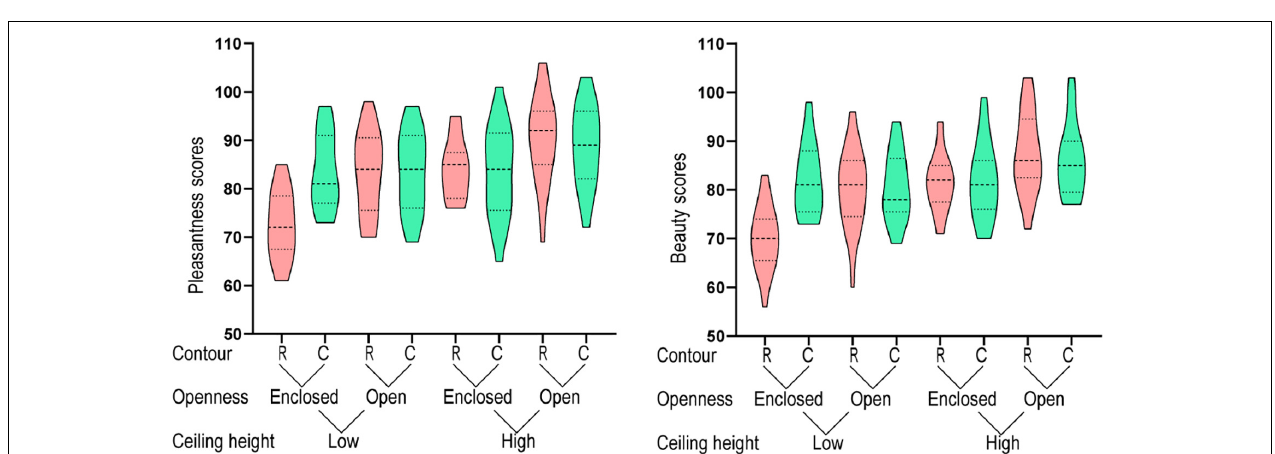
FIGURE 4 | Results for the grayscale-image